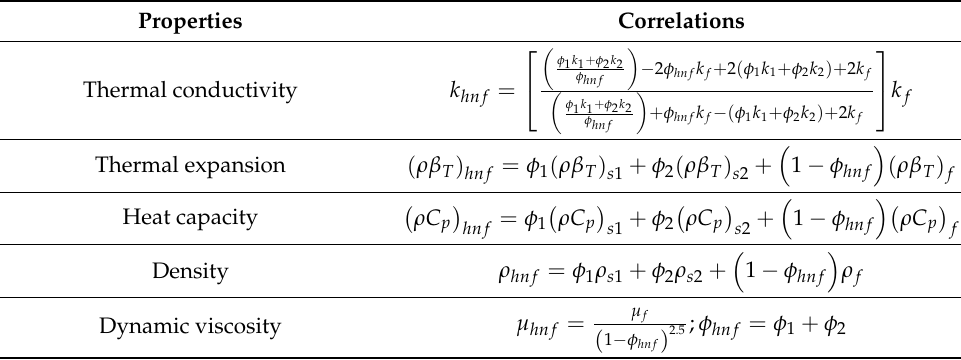
Table 1. Correlations of hybrid